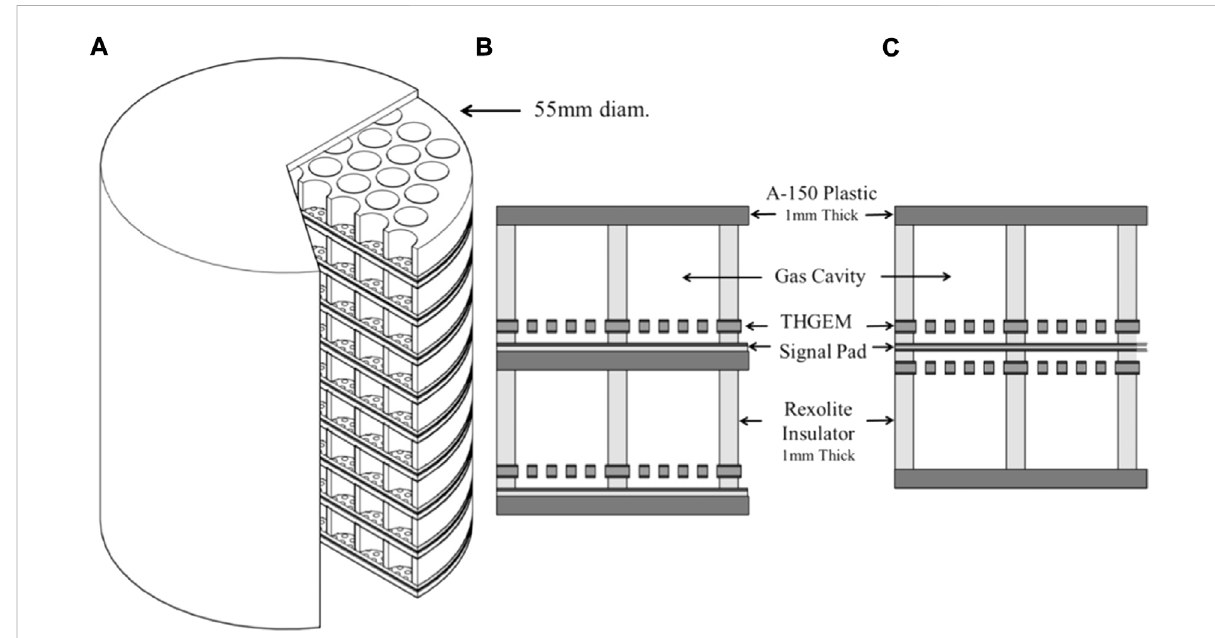
FIGURE 6 A 3D view of a 61 × 9 sensitive volumes TGEM-based TEPC (A) , and schematic details of two different assembling option (B,C) . Source: